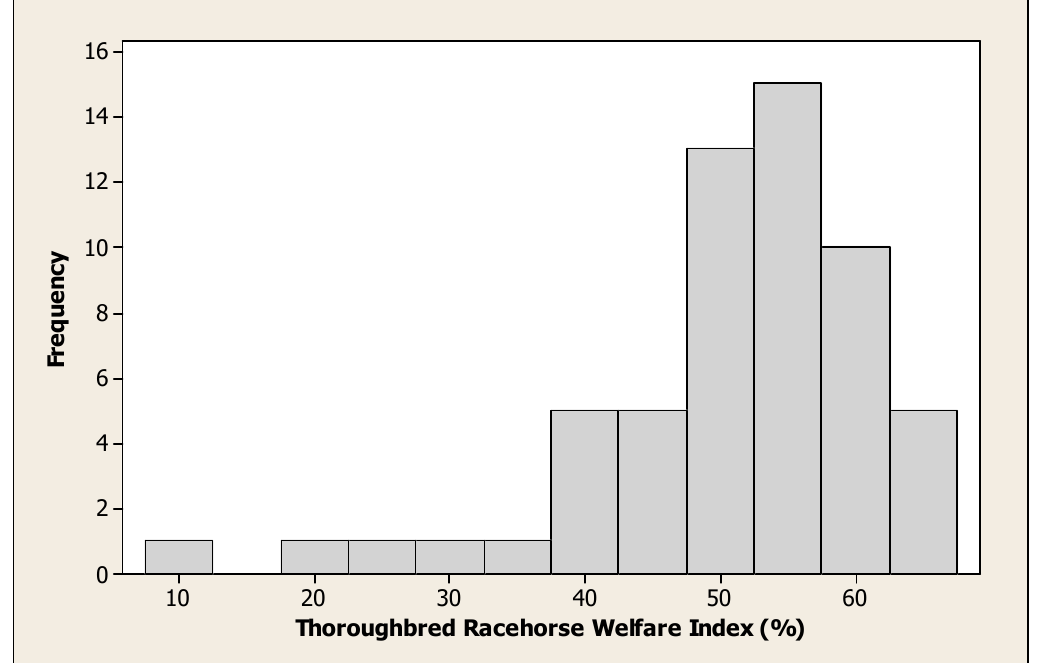
Figure 5. Distribution of TBRWI scores (%) for the 58 trainers responding to the survey in Study 2. In Figure 6, we depict the summary information for the welfare issues—arranged from the most important on the left to the least important on the right—in order to deter ‐